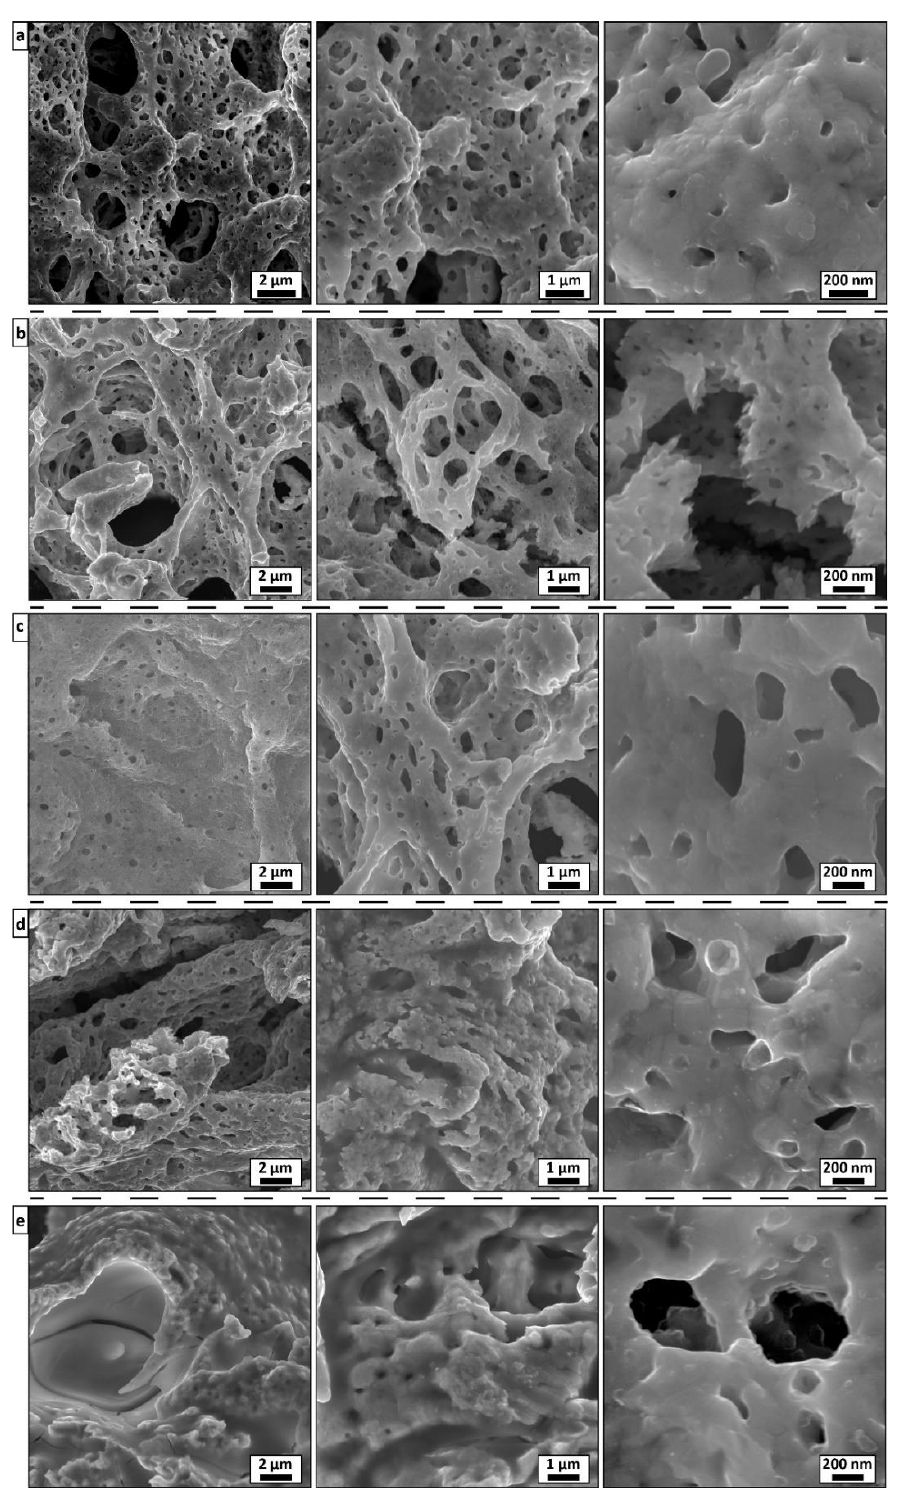
Figure 2. SEM images of ( a ) Co, ( b ) Co 3 Ni, ( c ) CoNi, ( d ) CoNi 3 , and ( e ) Ni bulk catalyst powders synthesized by